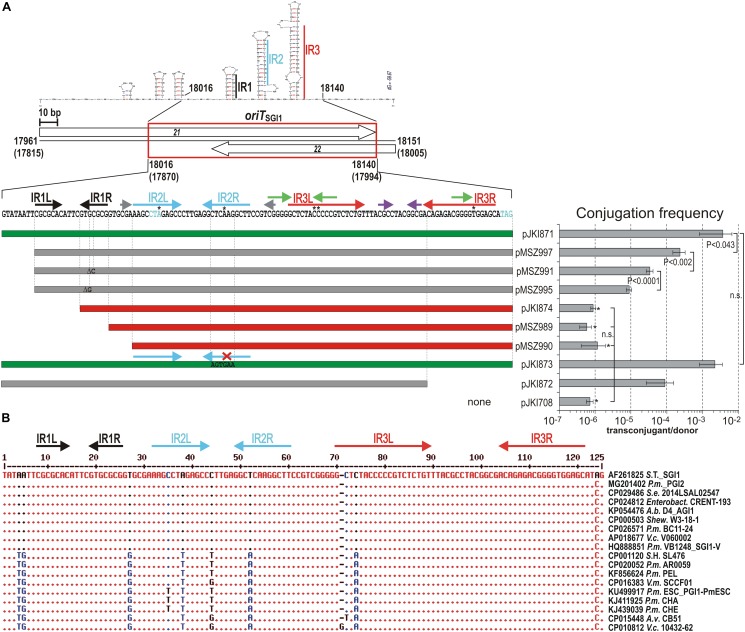
Mutation and comparative analysis of oriTSGI1. (A) Functional analysis of oriTSGI1. The location of fully functional oriT is indicated by red box in the schematic map. The SGI1 coordinates are indicated as in Figure 1. Repeated motifs are shown above the sequence by color-coded arrows. Left and right arms of the inverted repeats longer than 6 bp are designated as IR1/2/3L and R, respectively. Asterisks above the sequence indicate mismatching bases in the IRs. The potential secondary structure of the region and the stem-forming IRs are also shown. Shortened or mutated subclones of oriT are represented by color-coded horizontal bars: green – wt transfer rate; gray – reduced transfer rate; red – not mobilizable. Single base deletions and the sequence of mutagenized IR2R are indicated in the respective bars. The transfer frequencies of the pJKI708-derivative constructs were measured using the mobSGI1-donor and TG2 recipient strains. Asterisk indicates that the transfer frequency was close to or below the detection limit. The rare TcRSmR colonies carried also the helper plasmid (co-transfer was ∼100 %) indicating that they did not result from in trans mobilization of the test plasmids. In all statistical evaluations paired t-test was used to calculate the significance of the differences. n.s. – not significant, other symbols are as in Figure 1A. (B) Comparison of the homologous sequences to oriTSGI1 in SGI1-related elements found in the GenBank database. The alignment shows the sequence divergence in the oriTSGI1 regions of 63 fully sequenced relatives of SGI1 (for the entire list see Supplementary Figure S1). The 17 oriT sequences having divergent positions are shown, while those identical to the reference sequence are represented by the respective region of the published SGI1 sequence AF261825. Short names of bacterial strains and the SGI1 variant/relative is indicated after the GenBank acc. number of the sequences. Abbreviations are as follows: A.b. – Acinetobacter baumannii; A.v. – Aeromonas veronii; Enterobact. - Enterobacter sp.; P.m. – Proteus mirabilis; S.e. – Salmonella enterica; Shew. – Shewanella sp.; S.T. – Salmonella Typhimurium; S.H. – Salmonella Heidelberg; V.c. – Vibrio cholerae; V.m. – Vibrio mimicus.